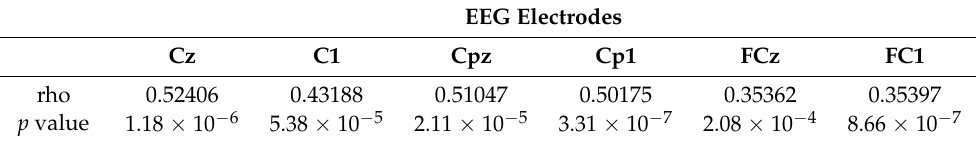
Table 3. Correlation coefficients of the alpha with deoxyHb in the LPMCdr cortical area during RF.